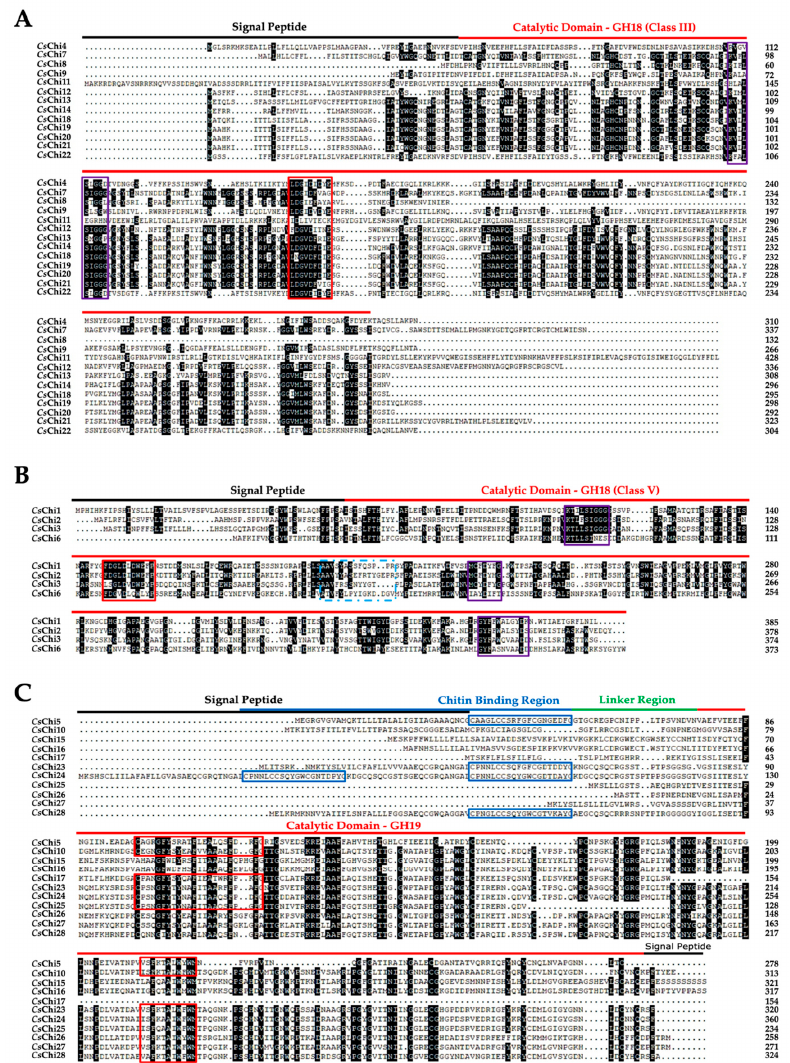
Figure 2. Multiple sequence alignment of the conserved domains of cucumber chitinase. ( A ) Sequence alignment of GH18 class III chitinases. Shaded amino acids are 50–100% homologous. ( B ) Sequence 150 alignment of GH18 class V chitinases. Shaded amino acids are 75–100% homologous. ( C ) Sequence 151 alignment of GH19 (class I, II and IV) chitinases. Shaded amino acids are 75–100% homologous. 152 Amino acid sequences were aligned using DNAMAN software (ver. 6.0). Black and red lines over 153 sequences indicate signal peptides and catalytic domain. While chitin-binding and linker regions are 154 indicated by blue and green line over sequence. Purple boxed residues are conserved. Blue box (dash 155 line) = PS00225, red box = catalytic domain and blue boxes = chitin-binding domain. 156